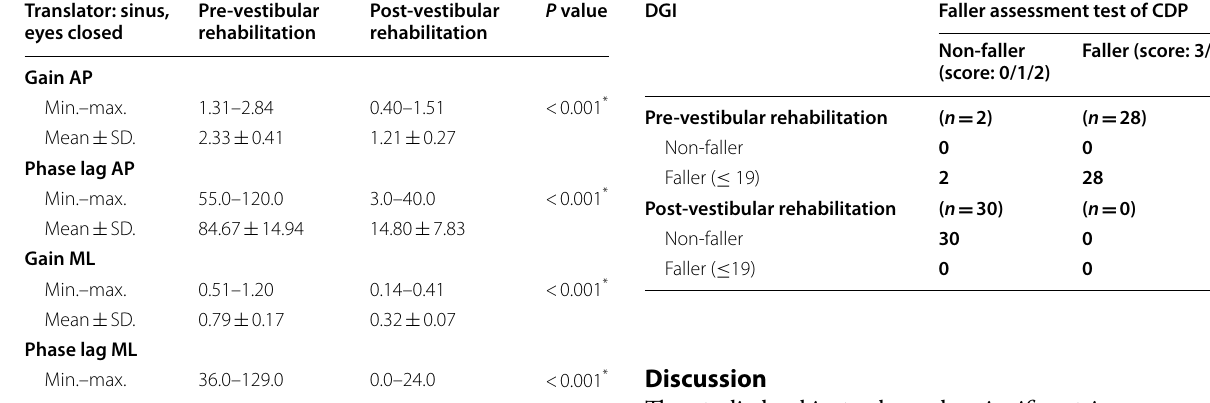
Table 18 Relation between DGI and faller assessment test in detection of those at risk of falls ( n =